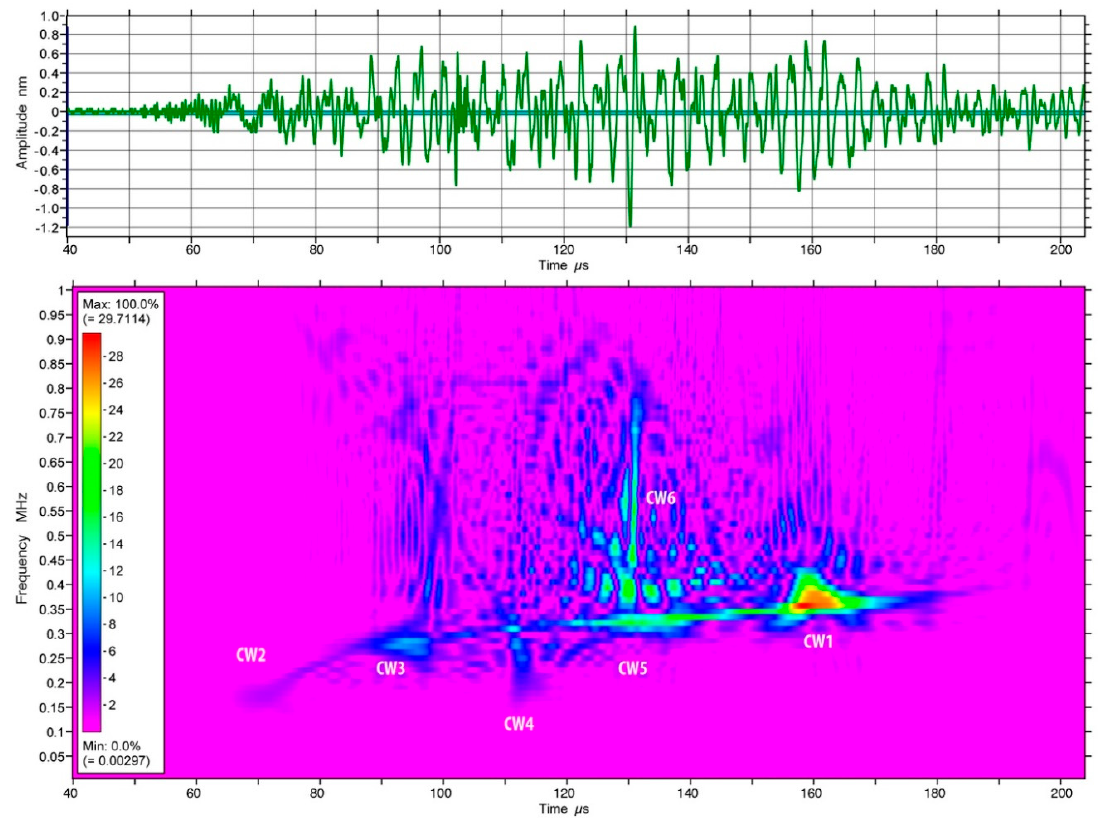
Figure 4. Displacement waveform from Figure 3a and its Choi-Williams transform spectrogram for 40–200 µs segment up to 1 MHz. Some peak positions are marked as cw1 to cw6.